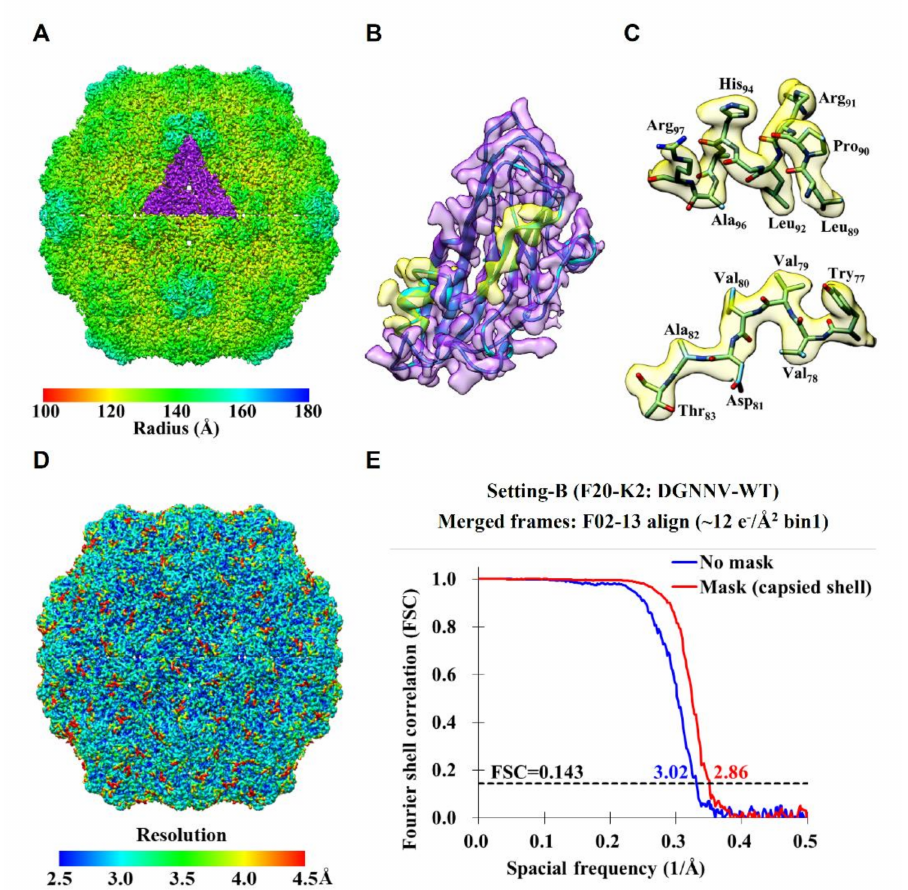
Figure 2. The sub-3Å cryo-EM structure of DGNNV particle from setting B. ( A ) The overall cryo-EM structure of DGNNV with the protrusions being computationally removed. The color spectrum from red to blue indicates the distance from the center where an asymmetric unit (ASU) of three capsid proteins segmented from the particle is colored in purple. ( B ) The density of capsid protein with S-domain only is in purple where the backbone within presented as ribbon is in cyan, and the selected α -helix and β -sheet are in transparent yellow. ( C ) Representative α -helix and β -sheet colored in transparent yellow. The atoms of oxygen, nitrogen and carbon are colored in red, blue and cyan, respectively. ( D ) Local resolution map of the DGNNV reconstruction (see also Figure S8). ( E ) Overall resolutions of DGNNV reconstruction estimated using gold-standard FSC for the un-binned data (bin 1 × ) processed by the classical algorithms